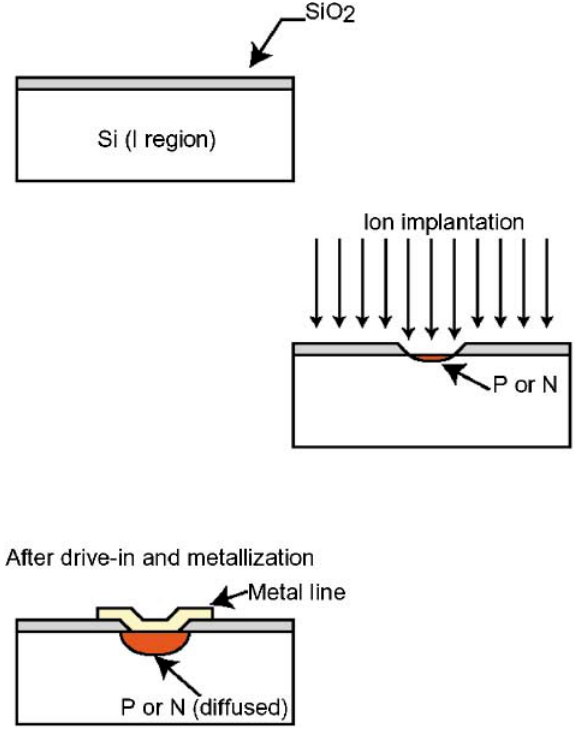
FIG. 11. (Color) Fabrication method.